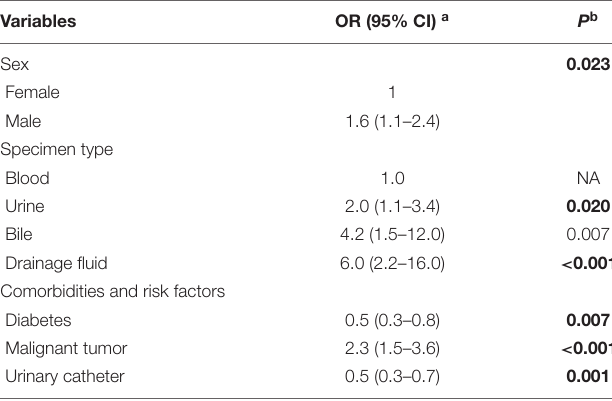
TABLE 2 | Multivariable logistic regression analysis of factors associated with mcr-1 -positive E. coli . Variables